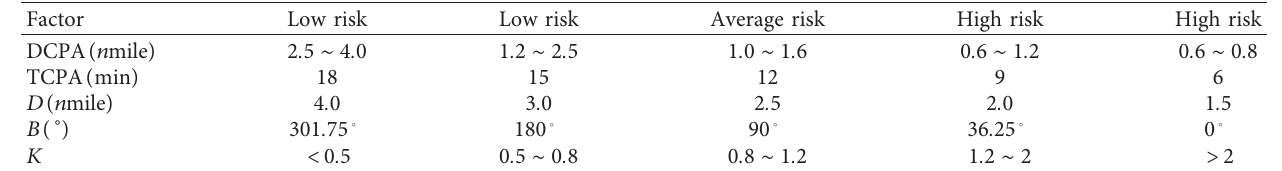
Figure 8: Ship speed ratio membership function image. Table 1: Criteria for risk evaluation of various factors.